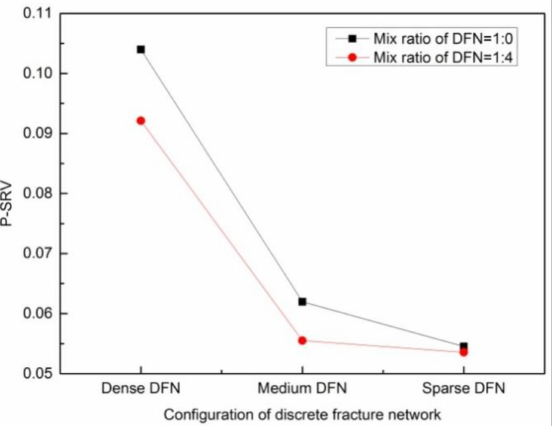
Figure 12. The plot of the index of P-SRV against dense, medium, and sparse DFN connectivity